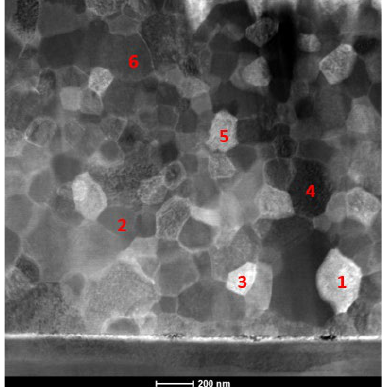
Figure 11. BF TEM cross-section micrographs of Al/Ni thin films after ignition by mode II. ( a ) φ = 0.05 mm W wire, and ( b ) φ = 0.20 mm W wire.